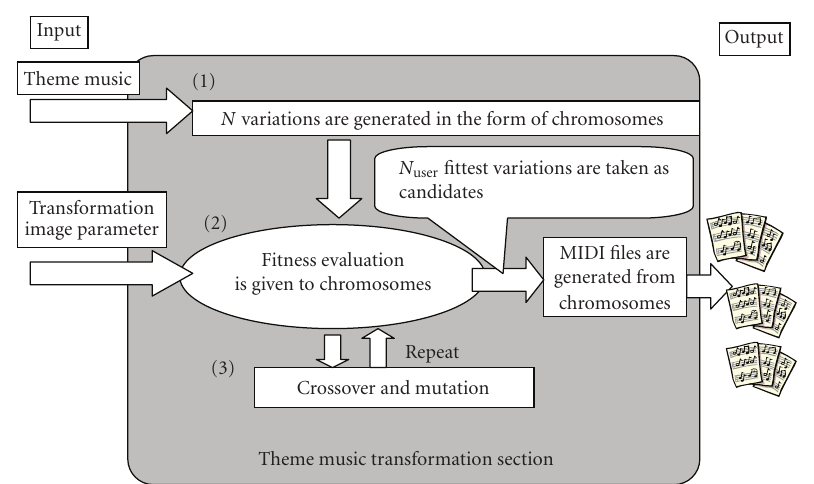
Figure 2: Theme music transformation section.